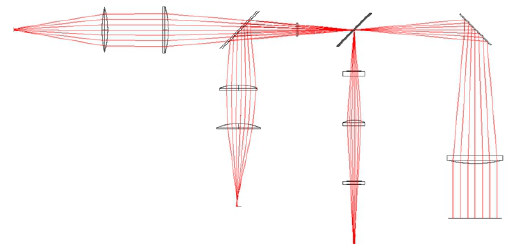
Figure 5. Three-channel optical receiving system simulation